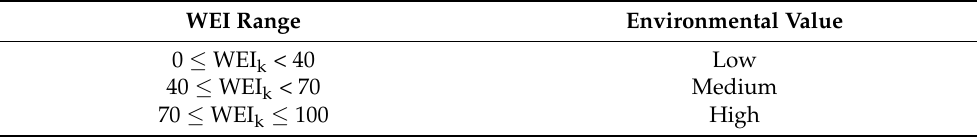
Table 1. Environmental value as a function of the WEI range.